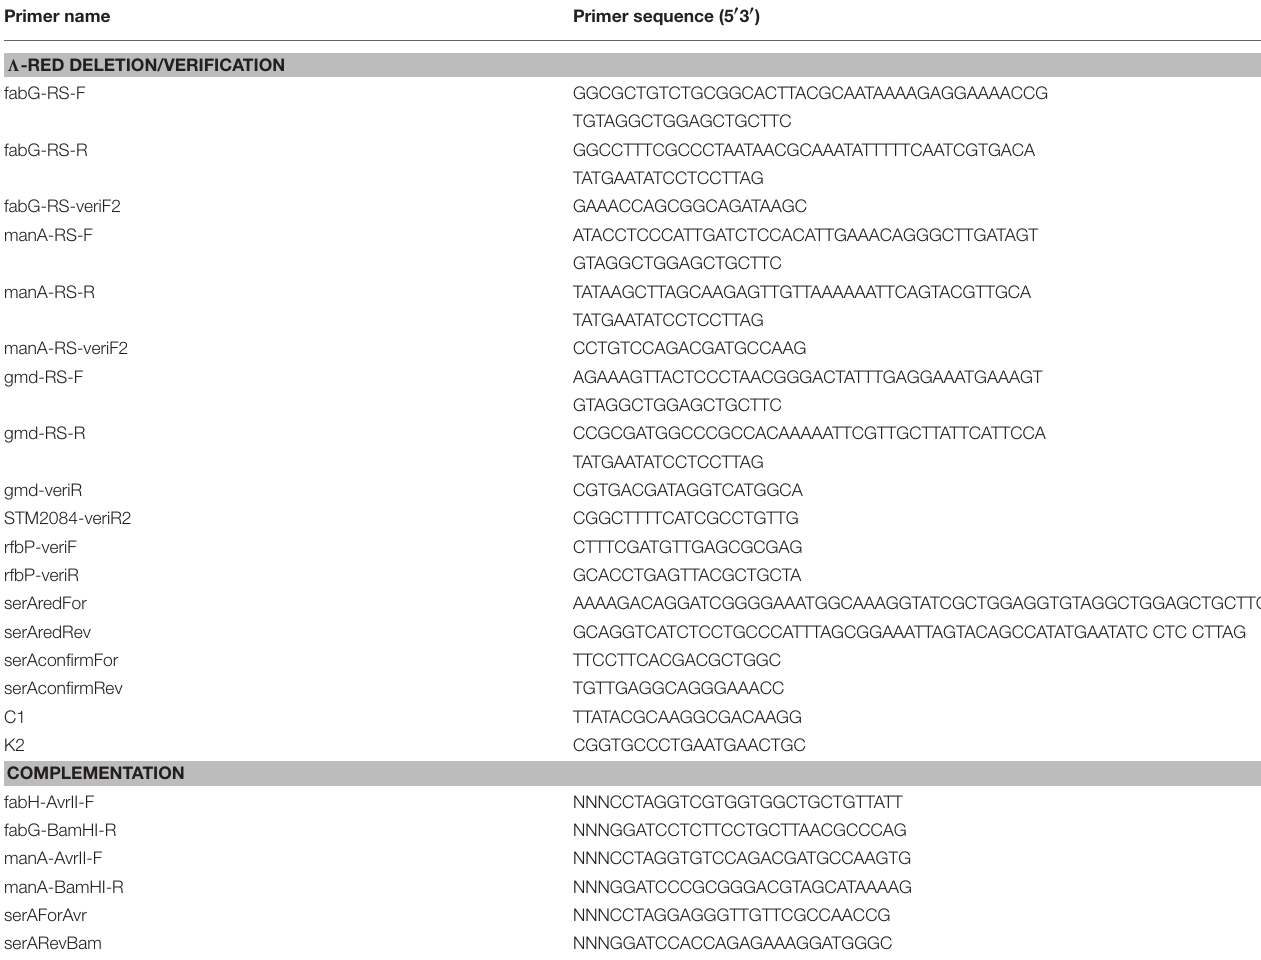
TABLE 2 | Primers used in this